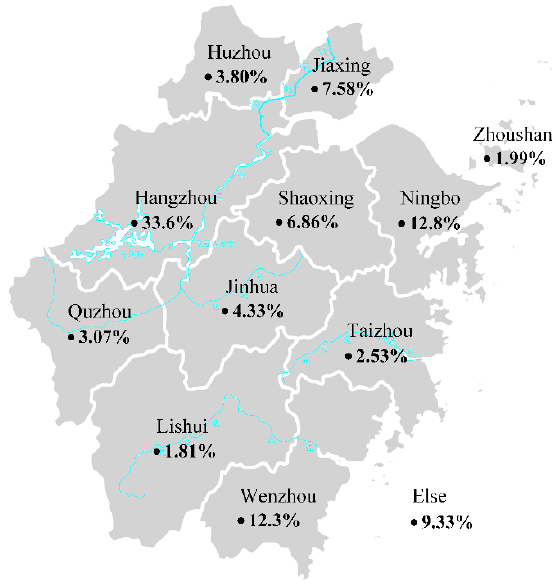
Figure 1. The region distribution of the questionnaire respondents.